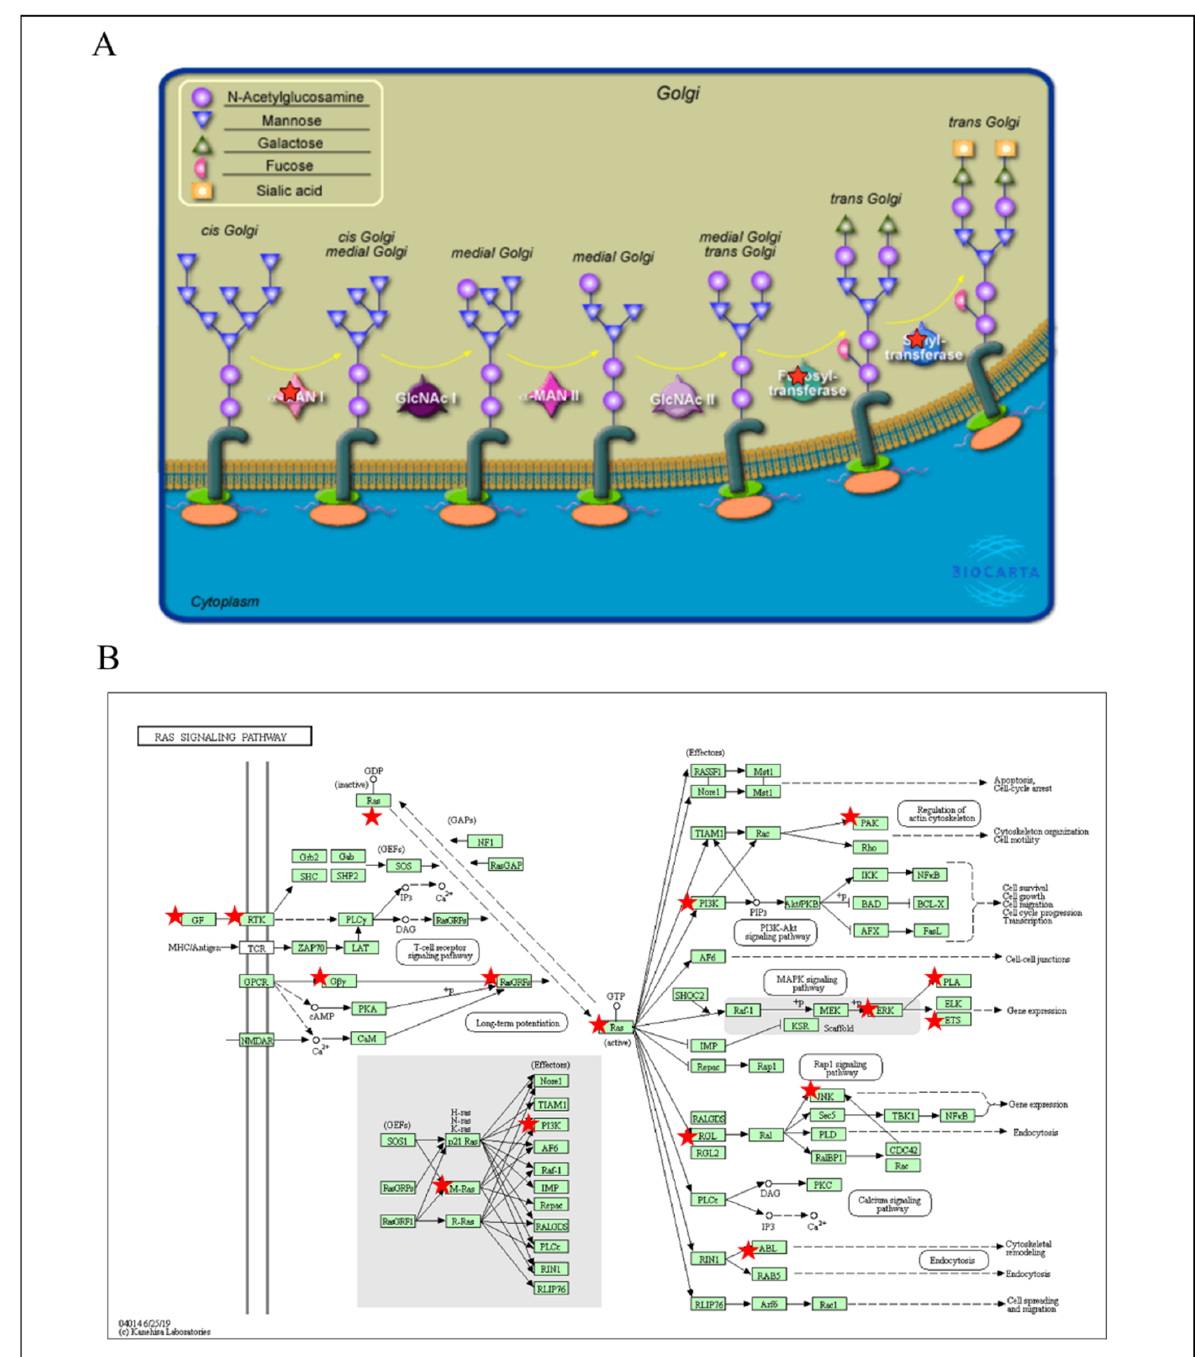
Figure 8. Pathway analysis for the co-expression of oxysterol-binding protein-like 3 (OSBPL3) in pancreatic ductal adeno- carcinoma (PDAC) via cBioPortal and DAVID platform. ( A ) Bar plot of BIOCARTA-plentiful terms of OSBPL3 in PDAC patients. ( B ) Bar plot of KEGG-enriched terms of OSBPL3 in patients with PDAC.